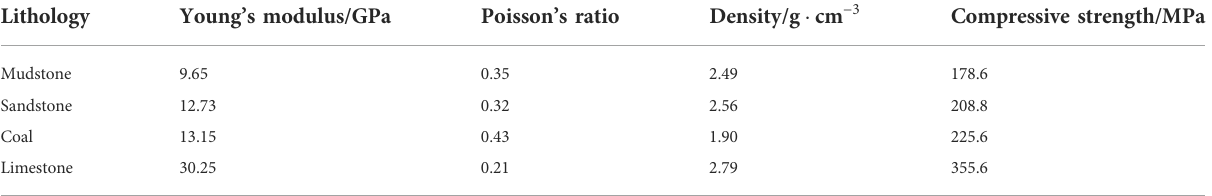
TABLE 1 Setting of petrophysical